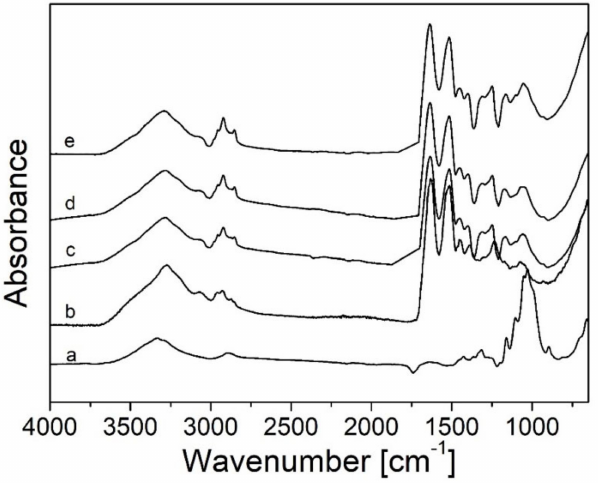
Figure 4. FTIR spectra of original wool, superheated water hydrolyzed wool, and kraft cellulose pulp: ( a ) 100% kraft cellulose pulp; ( b ) original wool; ( c ) 140 ◦ C hydrolyzed wool; ( d ) 150 ◦ C hydrolyzed wool; ( e ) 160 ◦ C hydrolyzed